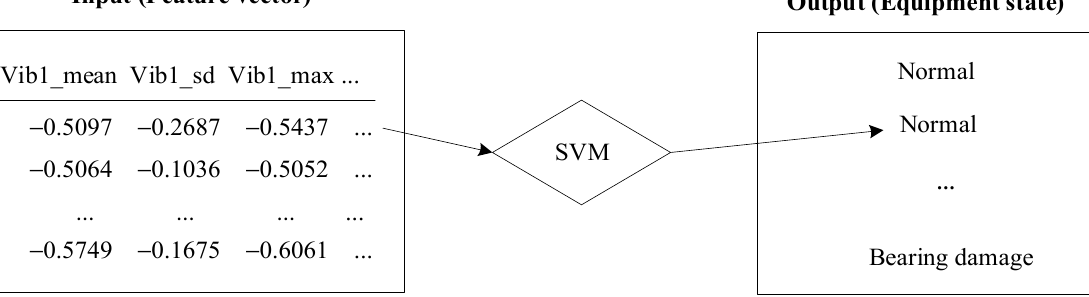
Figure 11. Classification model learning through SVM classifier.